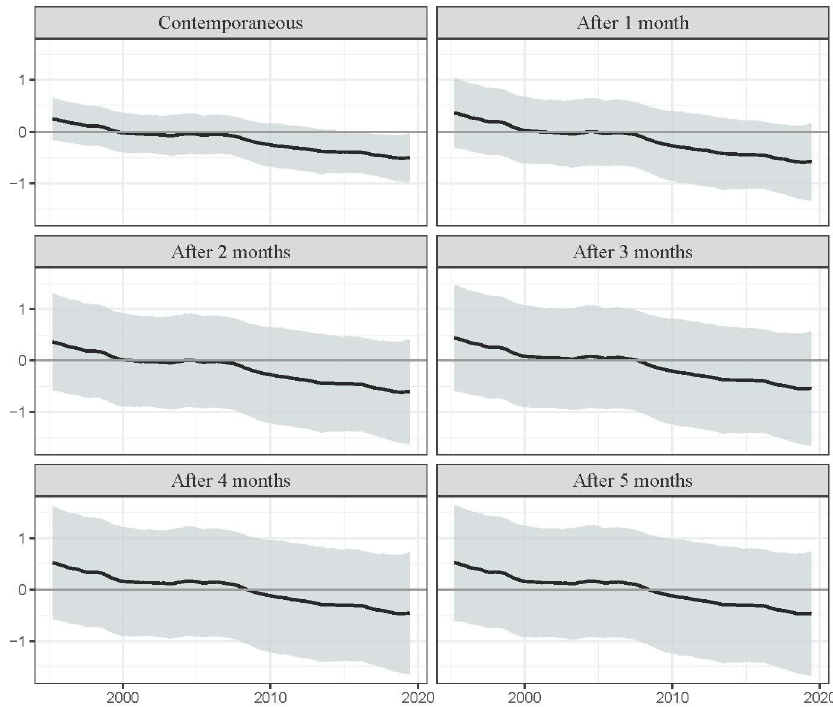
Figure A6. Responses of stock returns to an oil supply shock. Note: This figure presents the accumulated responses of stock returns to a one-unit oil supply shock in the first five months after the shock (1995:04–2019:06). The solid black line shows the mean while the gray area displays the 16th and 84th percentiles.